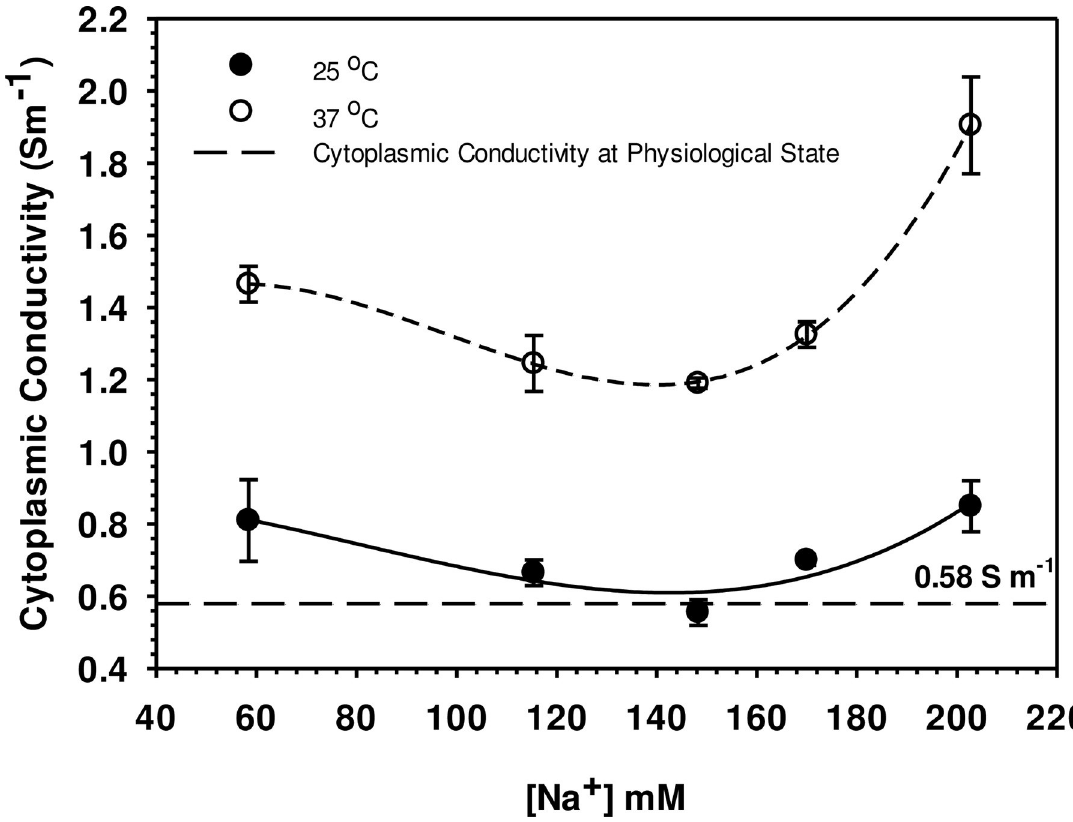
Fig 5. Calculated cytoplasmic conductivities over [Na + ] of suspending solutions at two desired temperatures. The calculations were carried out as that presenting in Table 2. The volume effect of haemoglobin has been allowed for by the introduction of the dilution coefficient term ( τ ) in Supplementary Eq. (5) in S2 File into ionic concentrations presented in column 2 of Table 2. The conductivity of normal blood has a conductivity of about 1.48 S m -1 . Values are means ± SE (n = 5, 5 separate individuals): the fitted lines are spline curves [35]. The Tukey test interval for testing for significant (p < 0.05) differences between any two mean cytoplasmic conductivity values was 0.340 S m -1 : conductivity was higher at 37˚C than at 25˚C at all [Na + ] tested. Conductivities at the two temperatures were not significantly different but at [Na + ] above the control concentration (148 mM) there were significant increases in conductivity at both